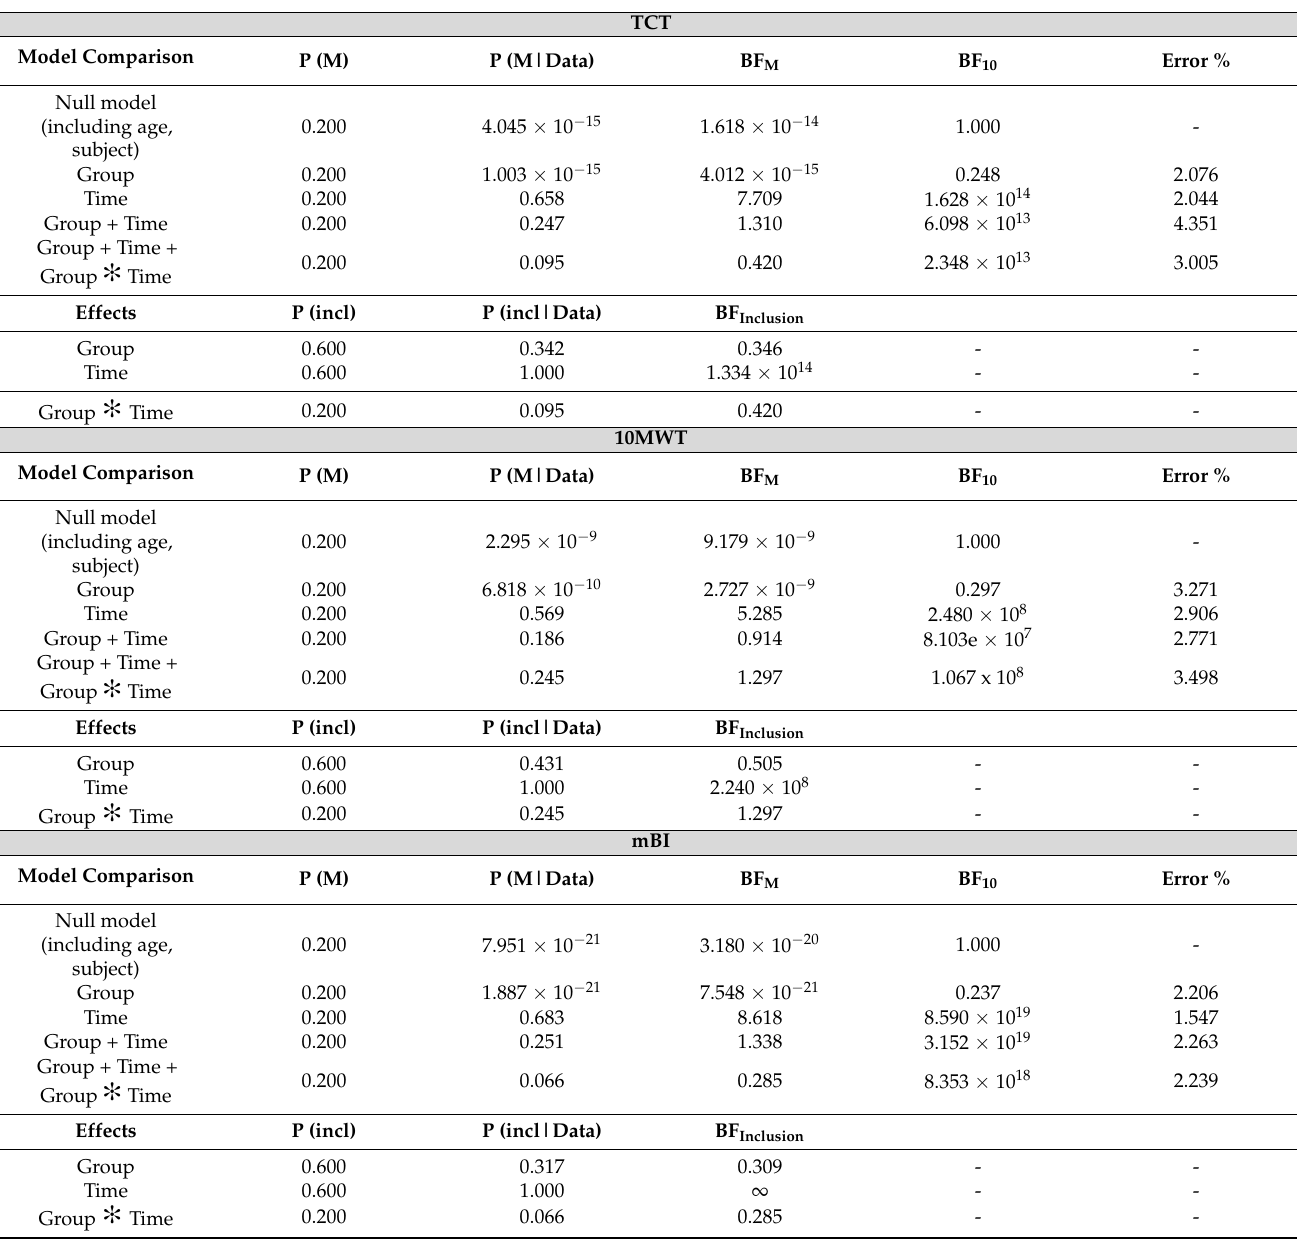
Table 3. Results of the chi-squared test between the Modified Ashworth Scale of the Affected lower Limb (MAS-AL), Functional Ambulation Classification (FAC), and Walking Handicap Scale (WHS) classes and the Experimental Group (EG) and Control Group (CG) samples.